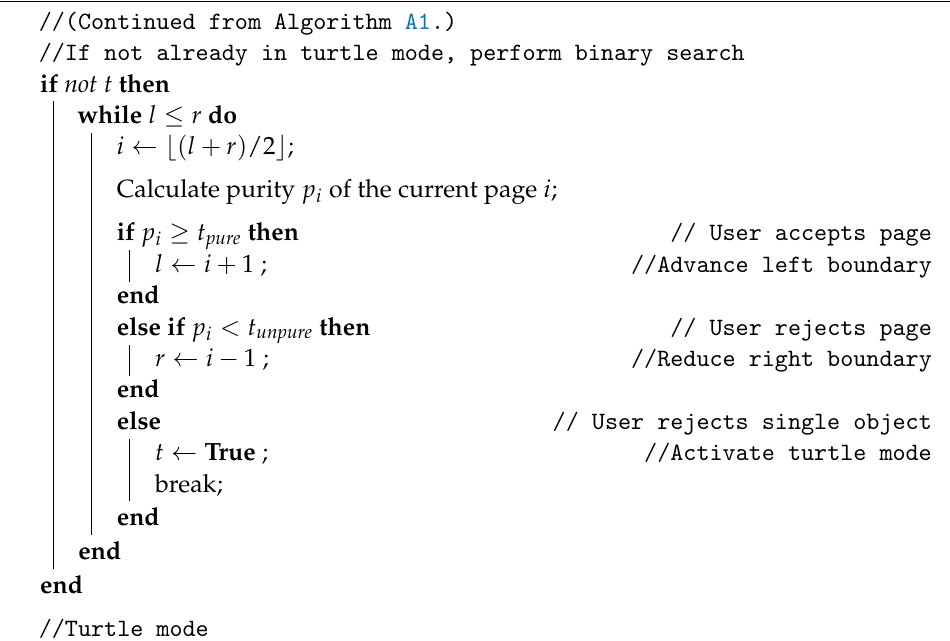
Algorithm A2: Growing: Binary Search and Turtle Mode //(Continued from Algorithm